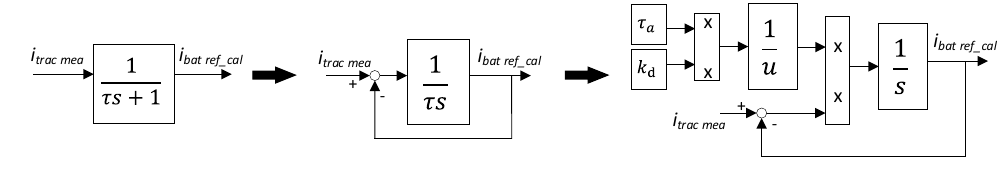
Figure 4. Adaptive low-pass filter transformation.